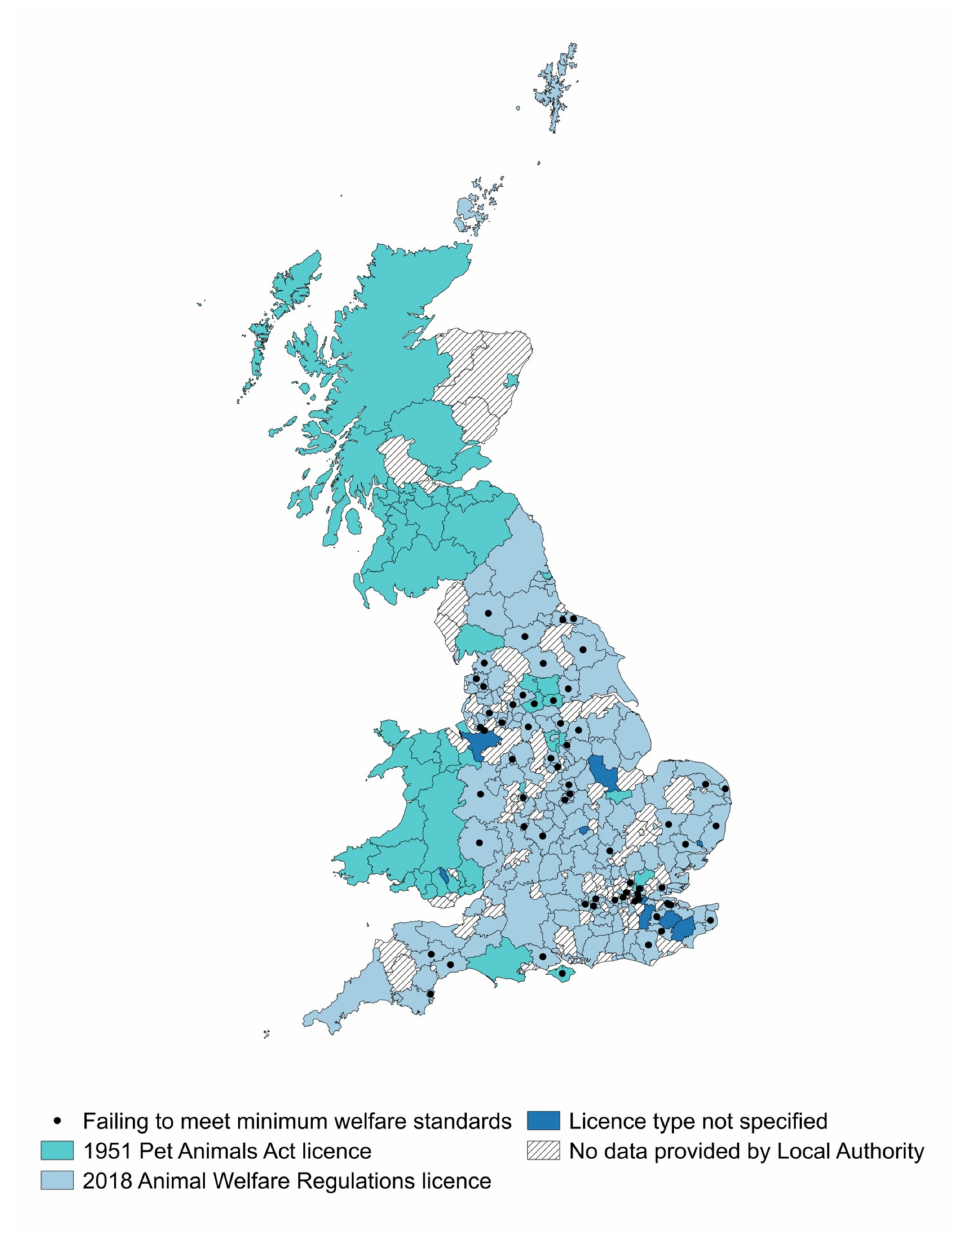
Figure 4. Map showing (i) the local authority areas (England only) where at least one pet trader had been issued a one star, indicating ‘Minor Failings’ in animal welfare standards (businesses that are failing to meet minimum welfare standards) (black dot), (ii) the local authorities issuing the 1951 Pet Animals Act licence, and those solely issuing the 2018 Animal Welfare Regulations licence, (iii) the local authority areas where pet shop licence information was provided via the FOI requests, but the licence type was not specified, and (iiii) the local authorities that did not respond to the FOI requests. The local authorities of Dorset, South Lakeland, North Tyneside, Wakefield, Wirral, and Kirklees were issuing a mixture of both old (1951) and new (2018)